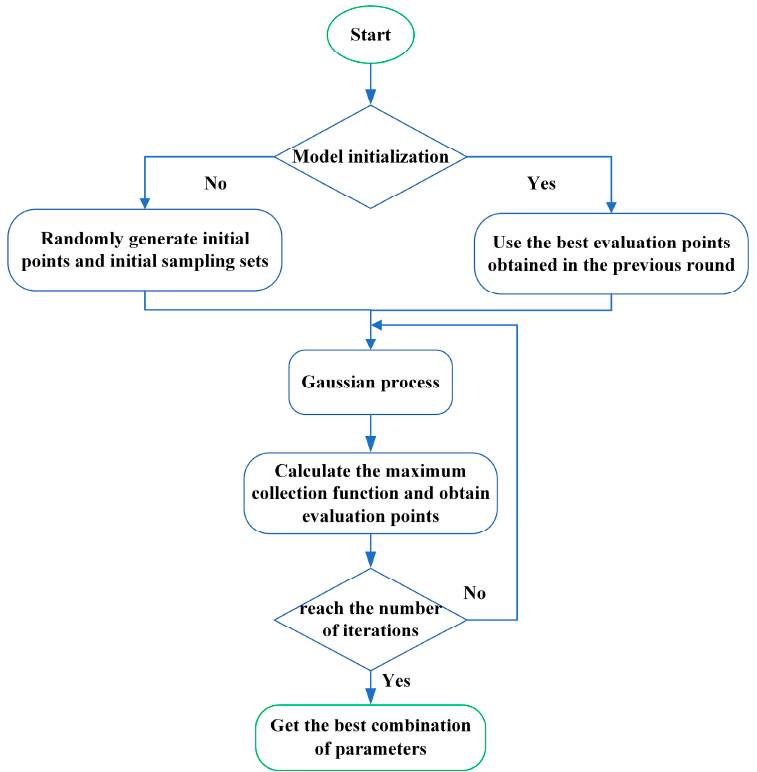
Figure 3. The process of Bayesian optimization.